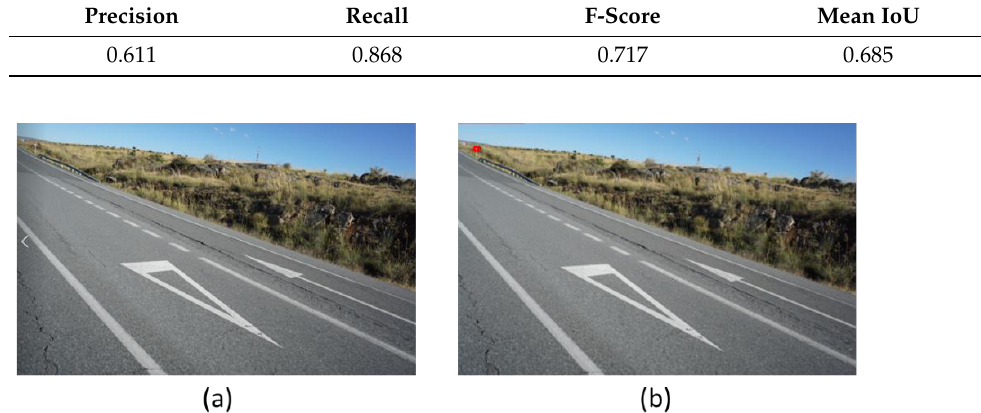
Table 2. Results of traffic signs detection using the deep learning architecture.